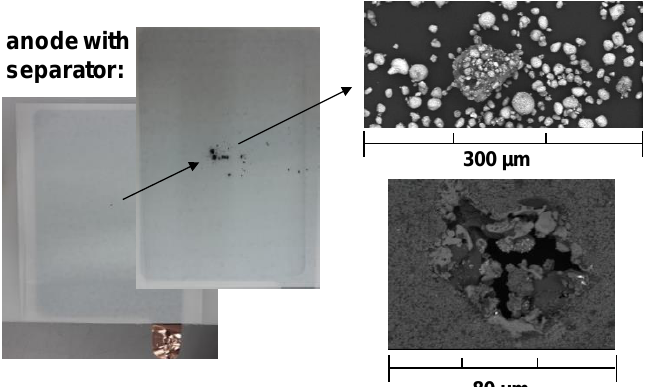
Figure 3. Cell stack including current collector, anode, and separator with forced defect structures. Optical images ( left ) and SEM images ( right ) of the forced defects in the separator, including agglomerates of molten cathode particles from laser cutting before the high-potential test (upper right), and the resulting separator defect holes after the high-potential test (lower right).